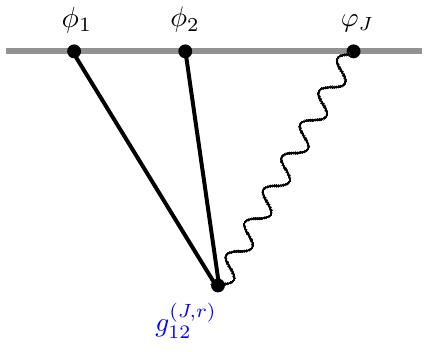
Figure 1 . Boundary three-point function of two scalars φ 1 , 2 and a spin- J partially massless field ϕ J of depth- r in de Sitter space, with coupling g ( J,r ) 12